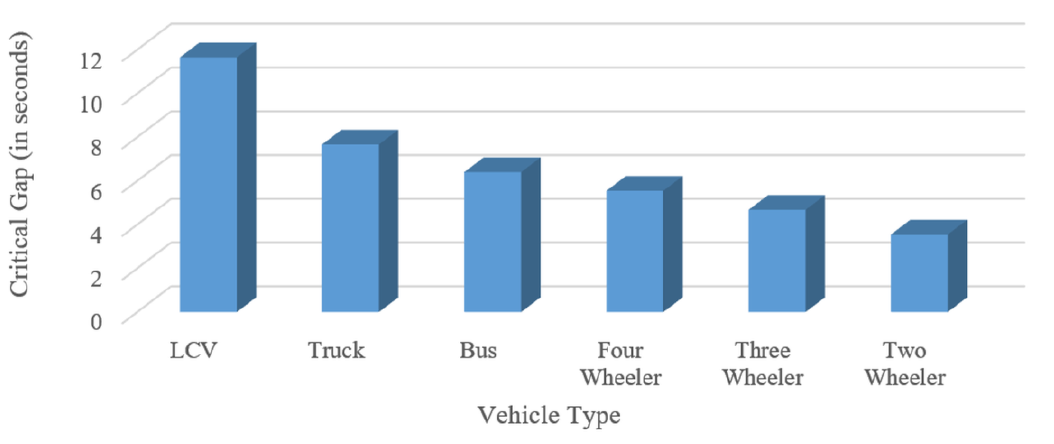
Figure 3: Critical gap for different classes of vehicles at a four-arm uncontrolled intersection